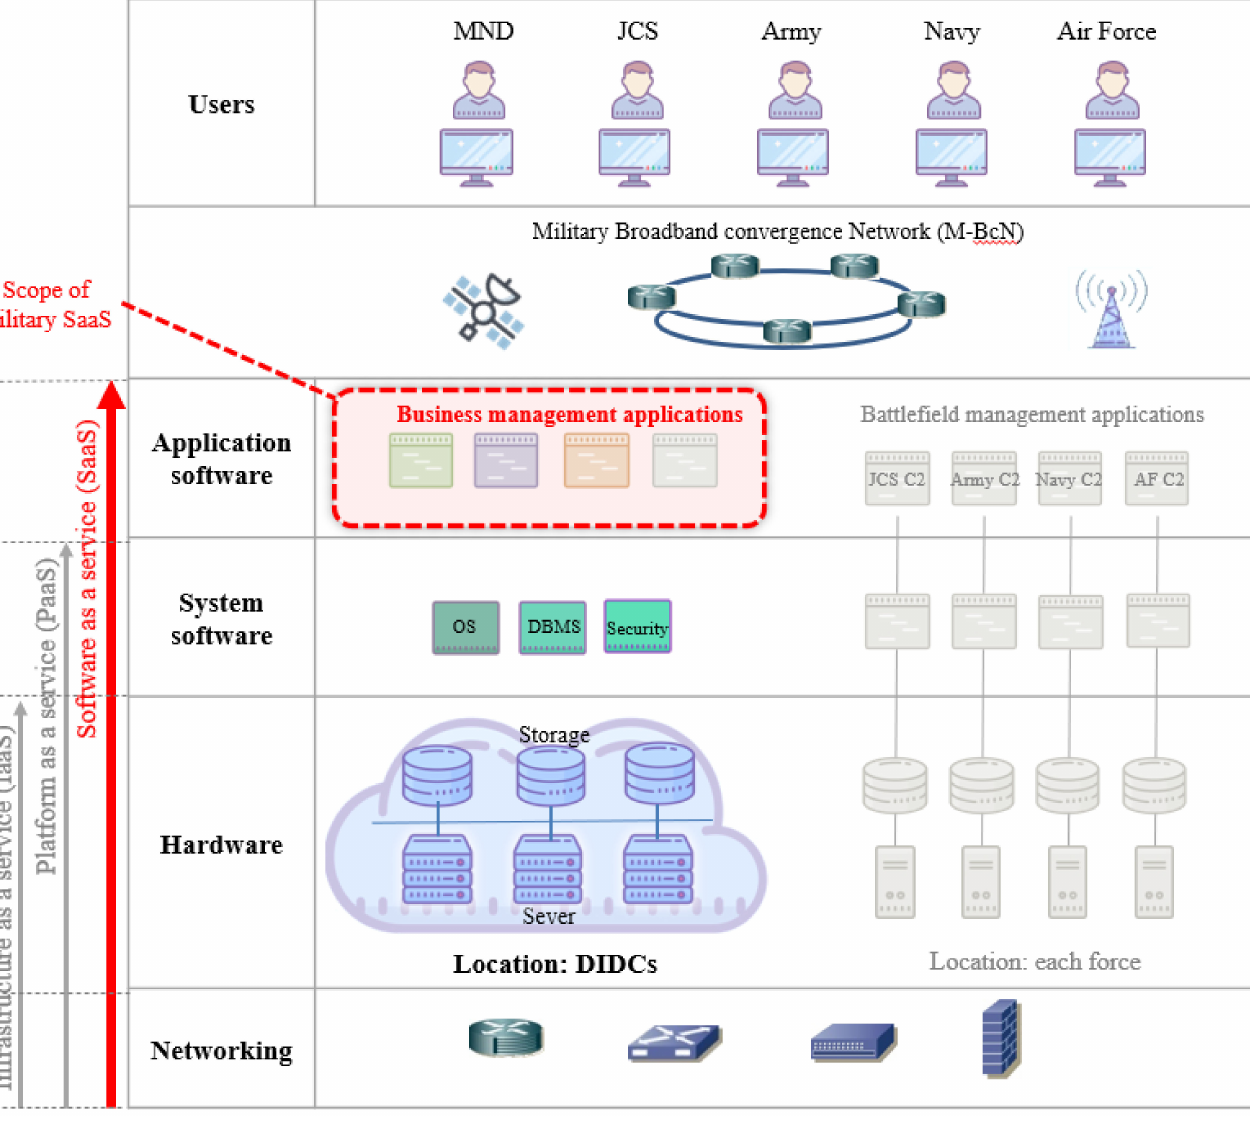
Figure 1. Military cloud